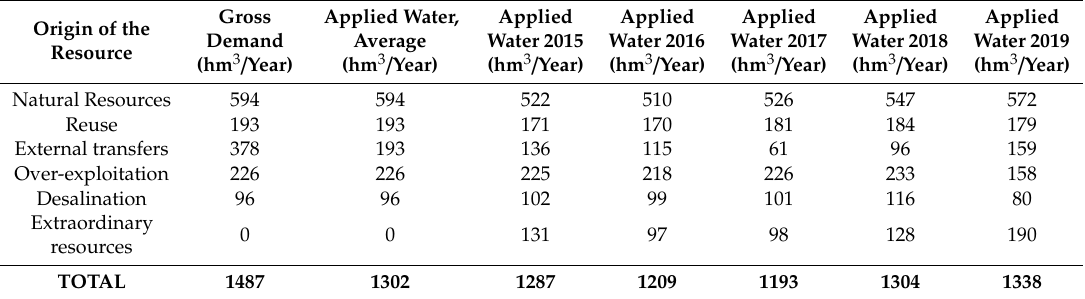
Table 8. Origin of the applied water resources 2015–2019 Source: HPO. Own elaboration. Origin of the